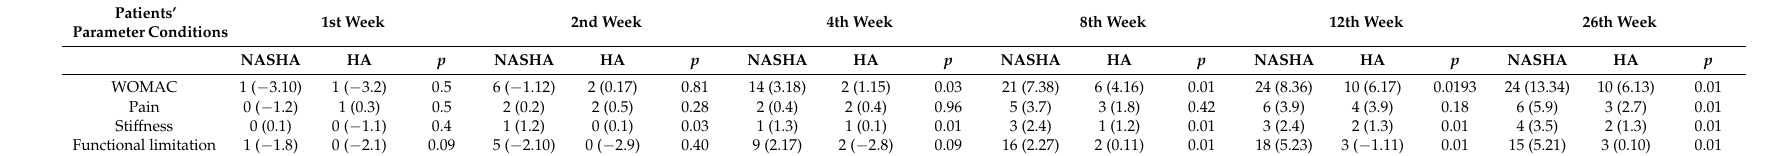
Table 4. Patients’ parameter conditions evaluation after 26 weeks of treatment with NASHA or HA.